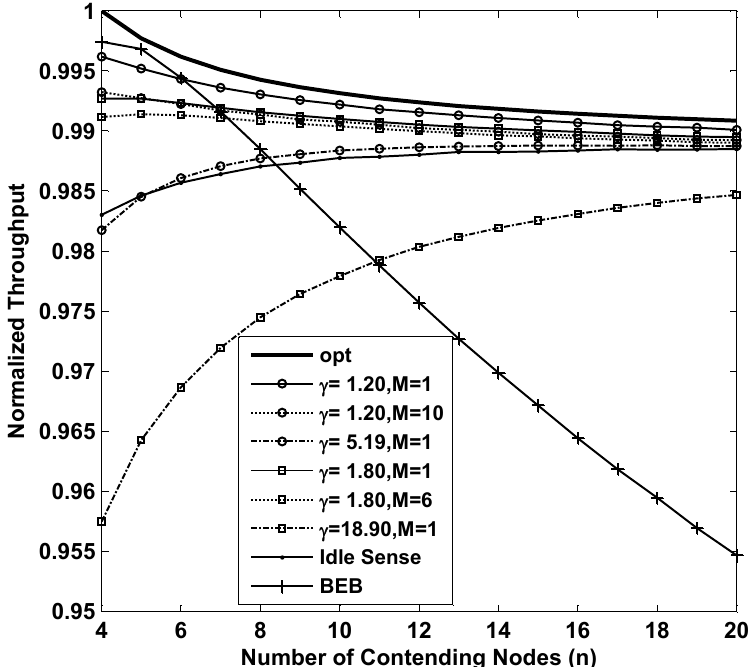
Figure 3. The normalized throughput performance of M -level contention window tuning algorithm with different M and γ , idle sense algorithm and BEB for sparse deployed